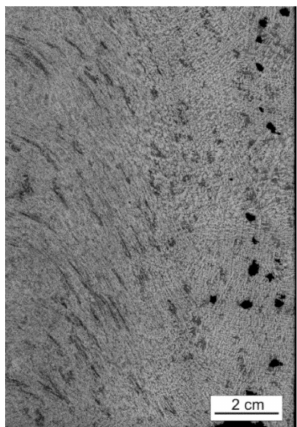
Figure 8. Part of the image after the histogram equalization and adaptation using the exponential method with the visible ‘grid’, which could not be clearly observed in Figure